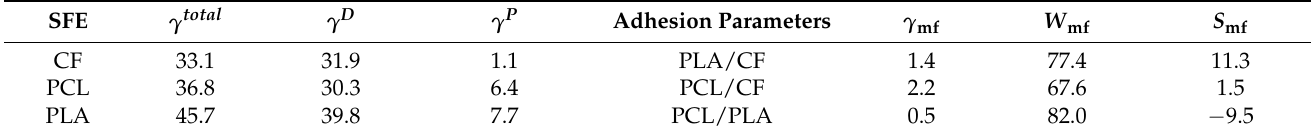
Table 5. Surface free energy and adhesion parameters in PCL/PLA/CF